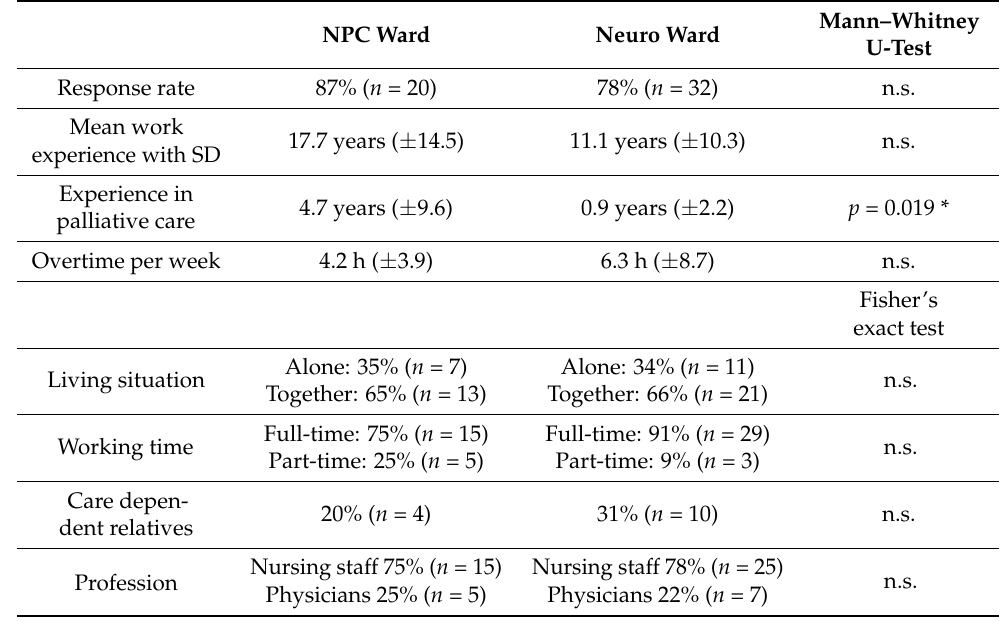
Table 1. Sample description of the NPC ward and the neuro ward with relative and absolute numbers. Mean and standard deviation ( ± SD) given. * Statistically significant differences ( p < 0.05). NPC Ward Neuro Ward